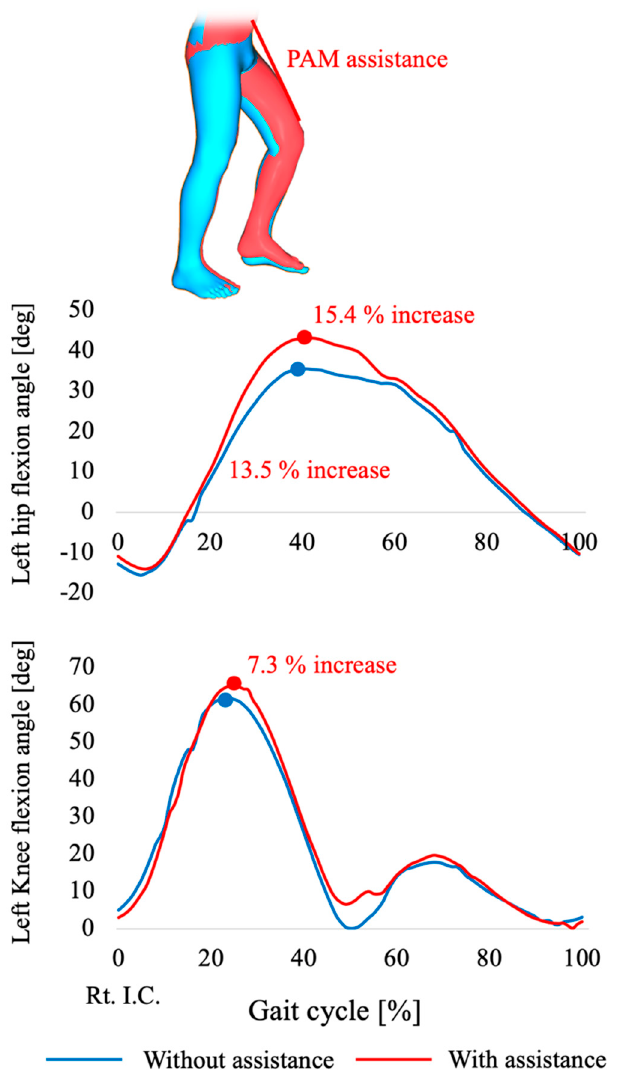
Figure 8. Graphical abstract. Example of body model and left hip and knee flexion angles in gait cycle activated by right initial contact (Rt. I.C.), which triggers the pneumatic artificial muscle (PAM) contraction. The blue and red model and lines signify without and with the PAM assistance, respectively. The peak flexion angles of hip and knee joints in the swing phase and the hip angular excursion were increased by 15.4%, 7.3%, and 13.5%, respectively, by the PAM assistance.